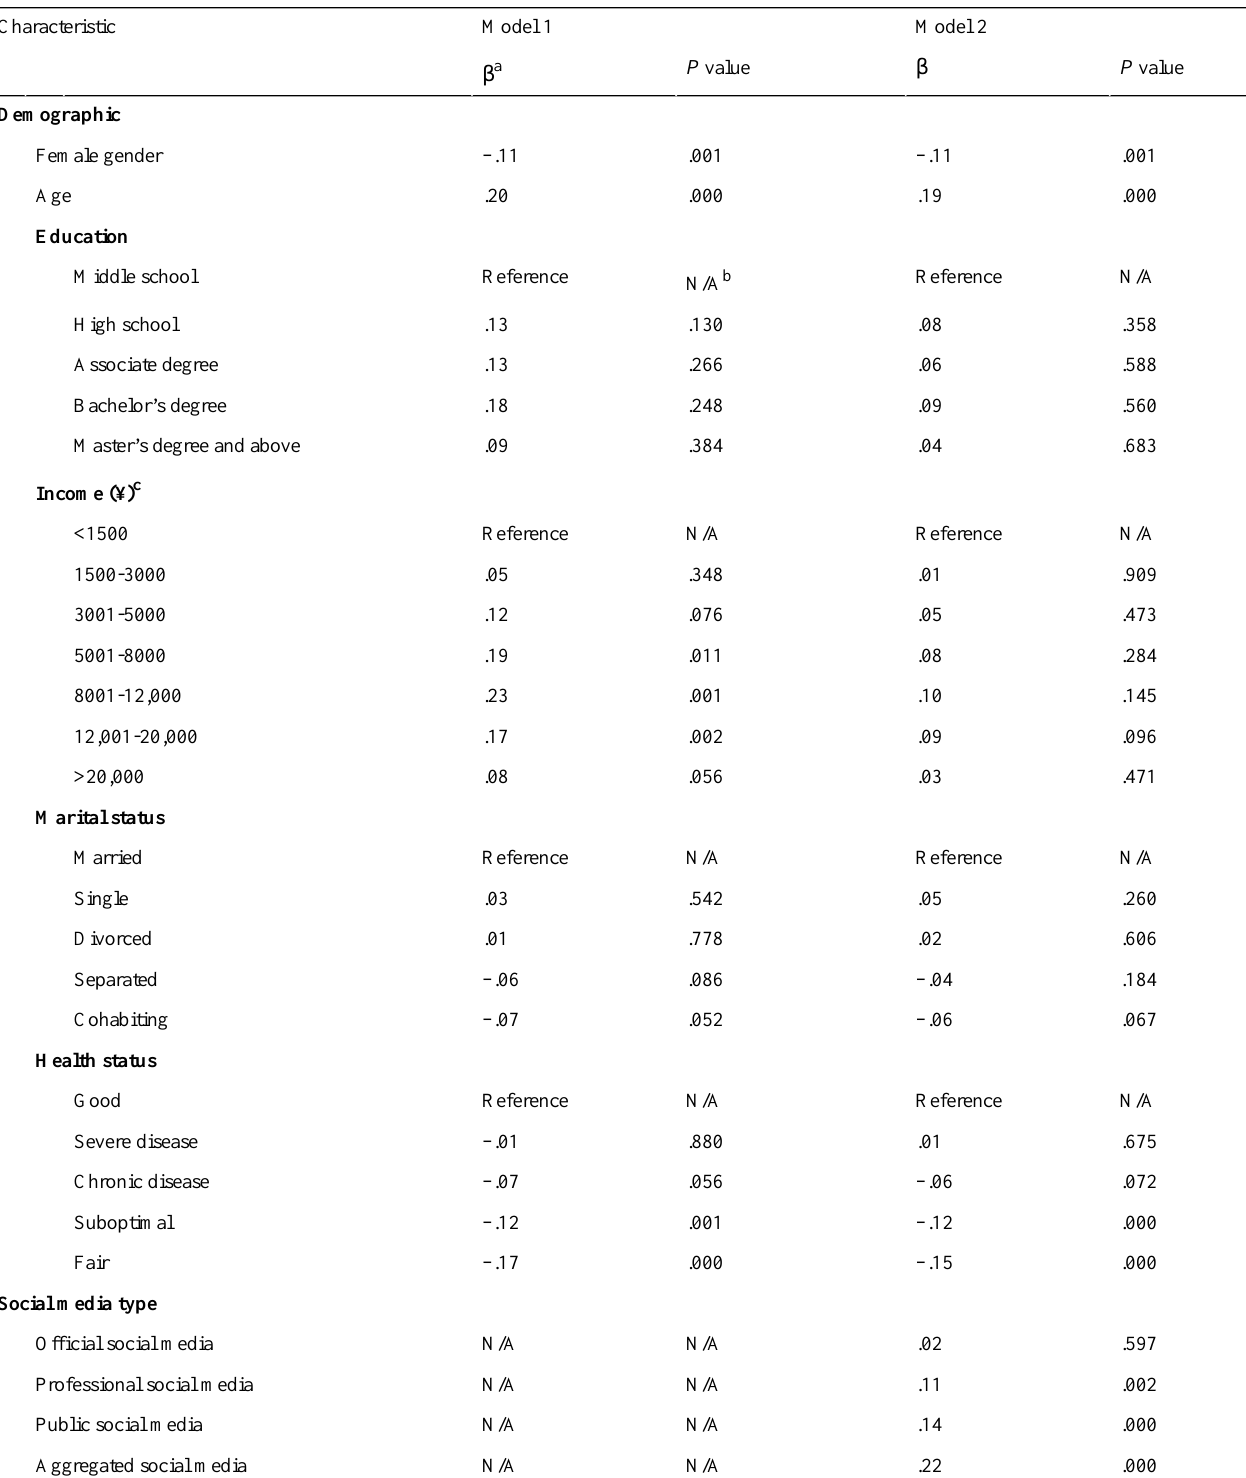
Table 4. Hierarchical multiple regression examining the predicting roles of different types of social media use on preventive behaviors.